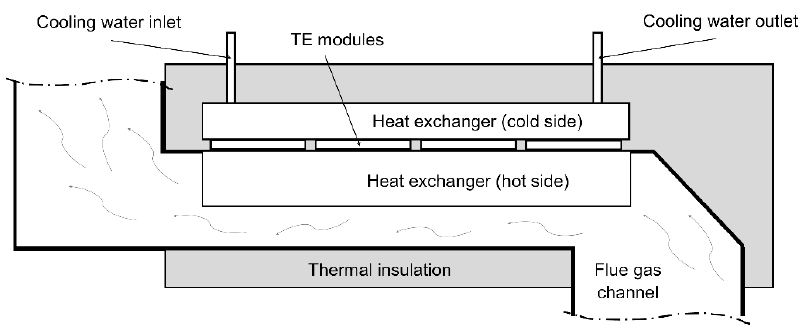
( d ) Figure 3. Key elements of the experimental rig: ( a ) wood-fired heating stove, ( b ) TEG prototype, ( c ) electronic load, ( d ) a PC with displayed visualization created in CoDeSys software. During the presented tests, 8 kg of pinewood with a moisture content of 12 – 13% and a lower heating value (LHV) of approximately 4.4 kWh/kg was burned. The Construction of the TEG Provided for Installation in the Chimney The hot side of the developed TEG was made in the form of a rectangular channel with a radiator. The shape of the exchanger was developed to increase the heat flux from flue gas to the hot side of TE modules (a change in flow direction by 90° provides better contact with the hot side of the TEG). The radiator was used to increase the surface of the